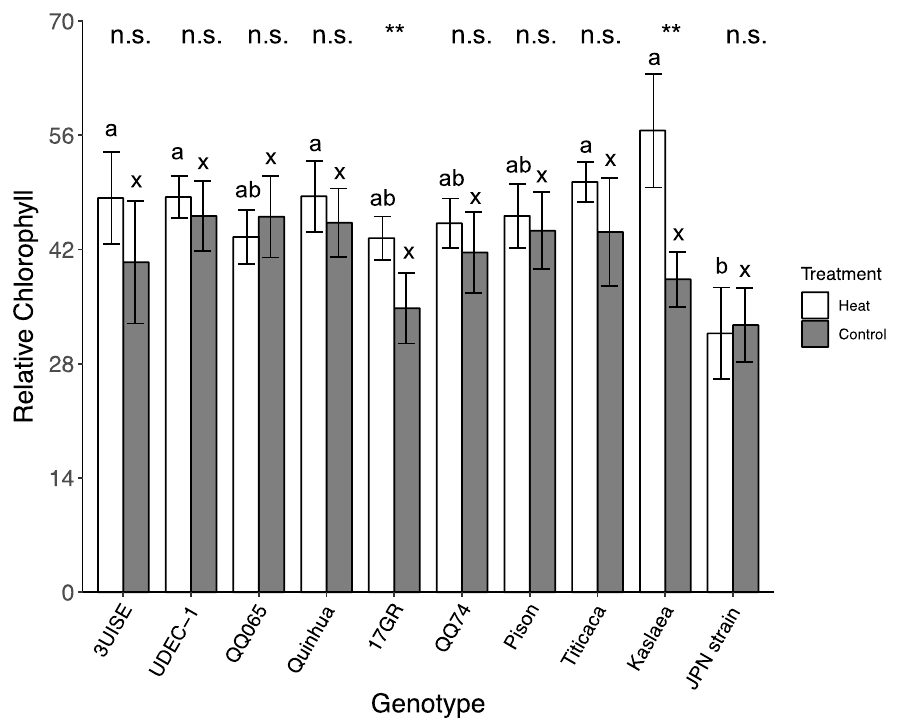
Figure 6. Relative chlorophyll for Day 4 in 10 quinoa genotypes exposed to a four-day heat treatment (45 °C/30 °C) and control treatment (20 °C/14 °C); day and night, respectively. Measurements were taken midafternoon between 14:00 and 15:30. Values are means ± SE ( n = 5–9). Mean comparisons are shown for within genotype (asterisks and n.s.) and within temperature treatment (Heat: a to b; Control: x); different letters are significantly different at p < 0.05; *, p < 0.05; **, p < 0.01; ***, p < 0.001; n.s., not significantly different.